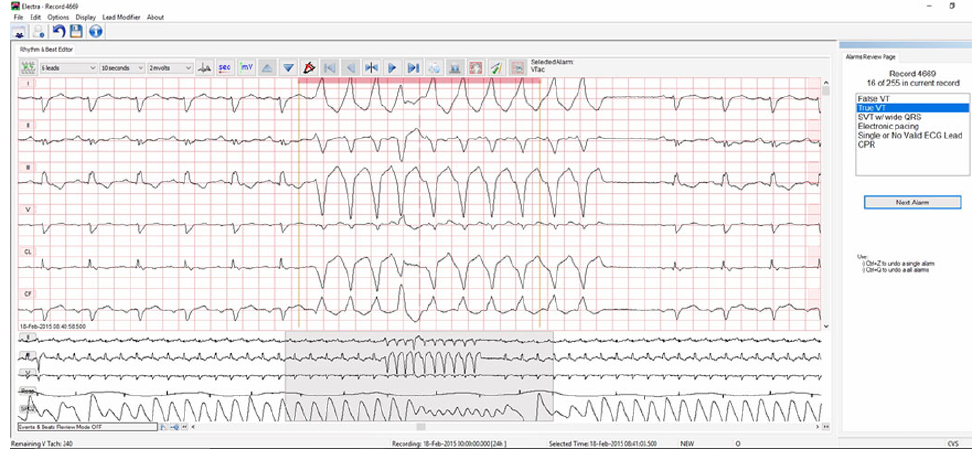
Figure 6. Illustrates an arrhythmia alarm for ventricular tachycardia ready for annotation using the Continuous ECG Recording Suite (CER-S) software program. The annotator selected a response (true, false, etc.) and then selected “Next Alarm” to move onto the next annotation. Note that an Sp02 waveform is shown in the bottom context view for use by the annotator when making a deci- sion. Arterial blood pressure is also available if the patient has this device in place. Figure from the